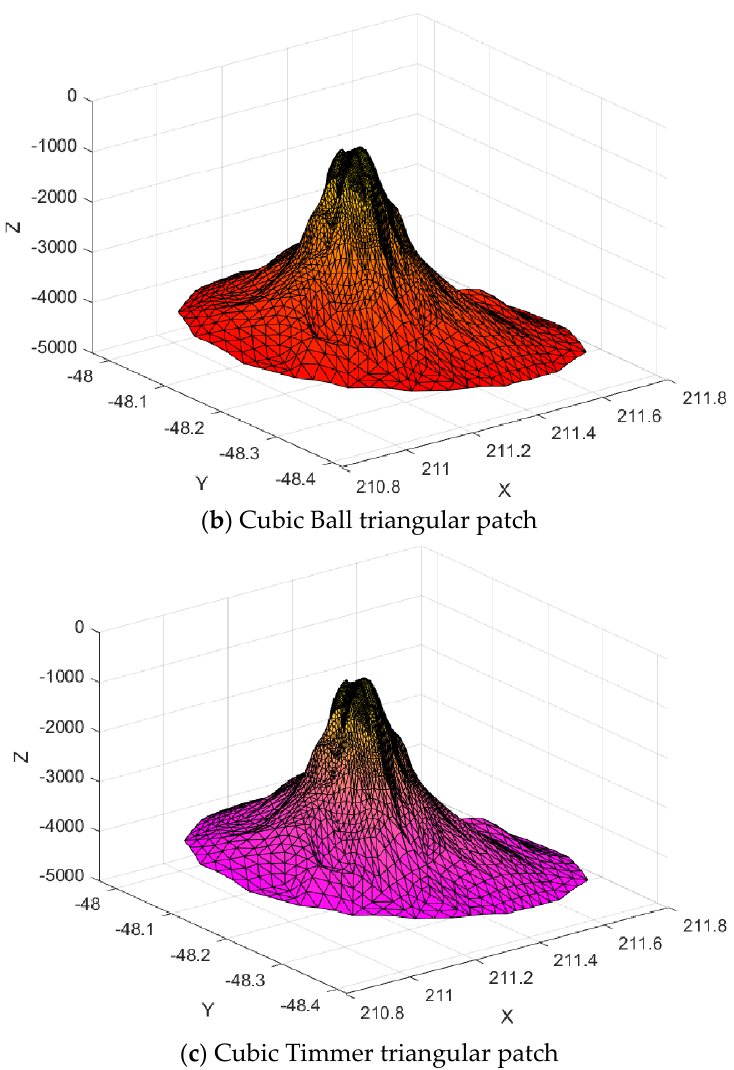
Figure 27. Surface interpolation.